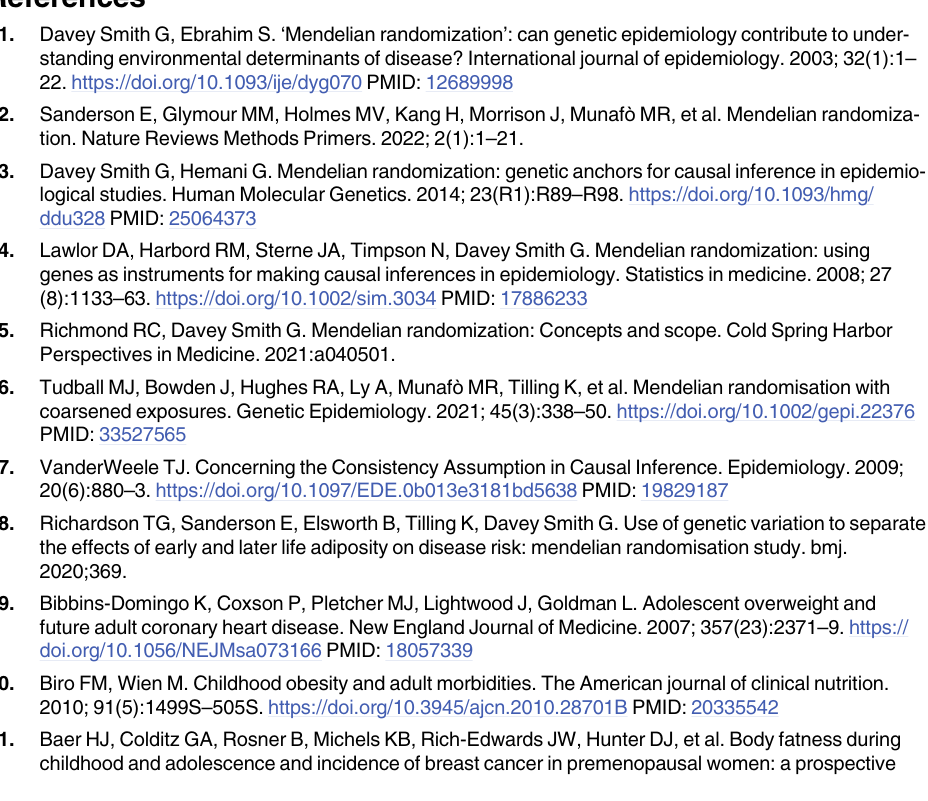
Table C–Additional 2.